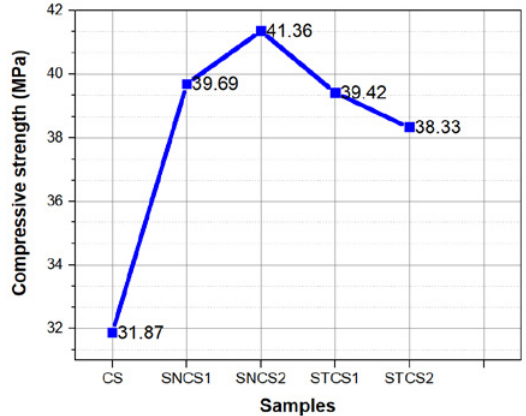
Fig. 4. TEM image and histogram of the length of TiO Figure 4. TEM image and histogram of the length of TiO 2 nanoparticles.